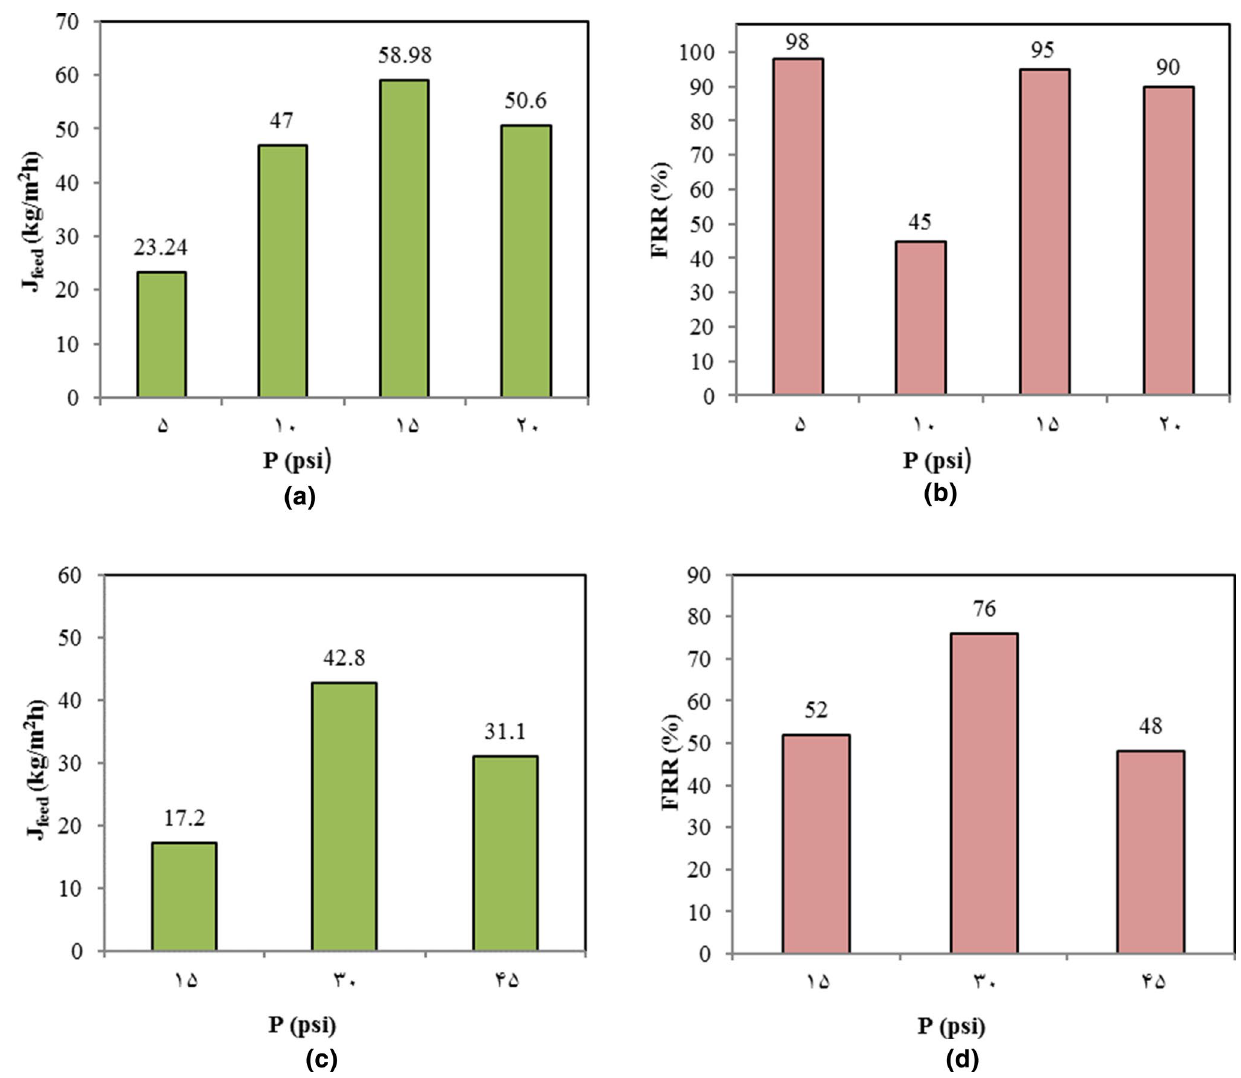
Fig. 8 J Feed ( a ) and FRR ( b ) measured for MF membrane and cillin wastewater (HRT = 16 h)